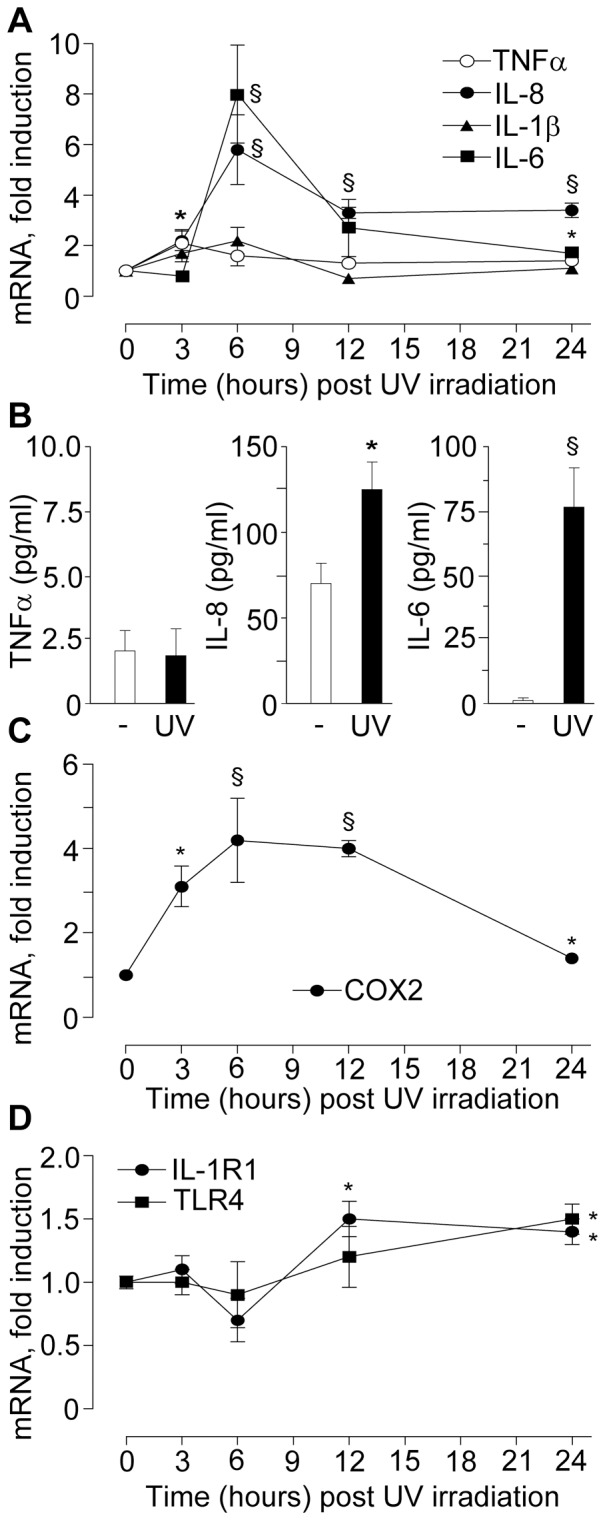
Inflammatory responses to UVA+UVB in normal human epidermal keratinocytes (NHEK).
A. Time course of post-UV cytokine transcripts; B. TNFα, IL-6 and IL-8 proteins in the conditioned medium of sham-irradiated NHEK and 24 h post UVA+UVB irradiation (1.0+0.1 mJ/cm2); C. Time course of post-UV COX-2 transcript; D. Time course of post-UV IL-1R1 and TLR4 transcripts. *P<0.05 and §P<0.01versus sham-irradiated control.